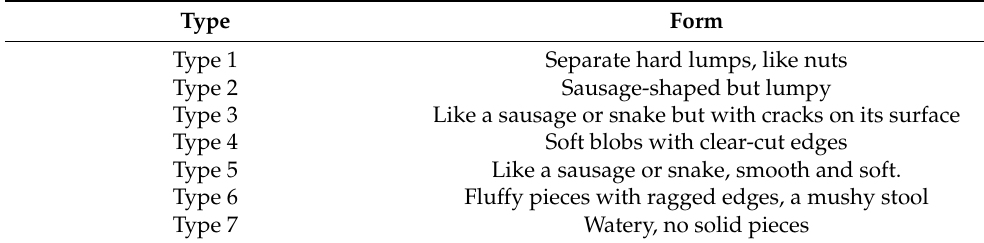
Table 2. Bristol Stool Form Scale. Type